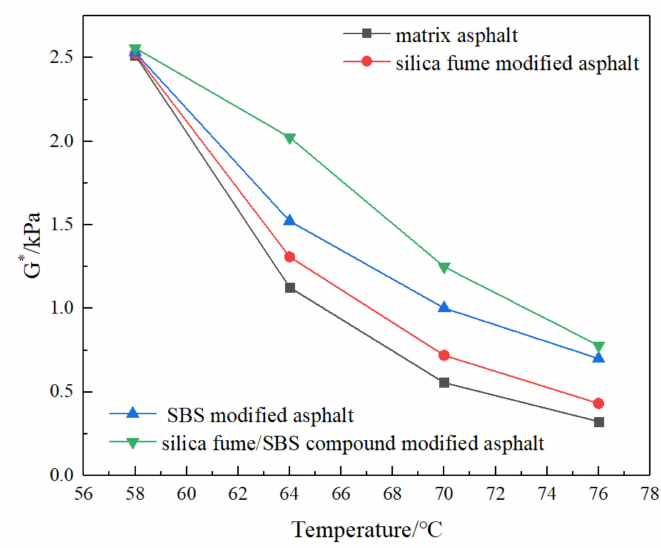
Figure 3. Curves of complex shear modulus G * of four kinds of bitumen with temperature.